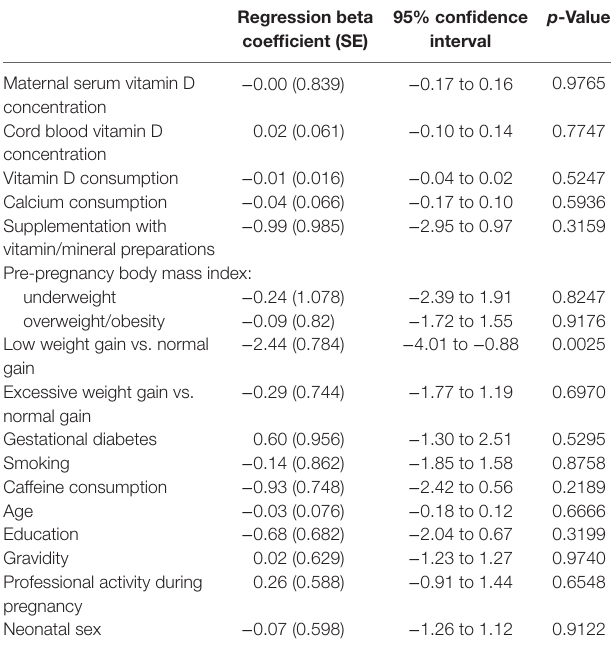
TaBle 3 | Relationship between selected parameters and neonatal